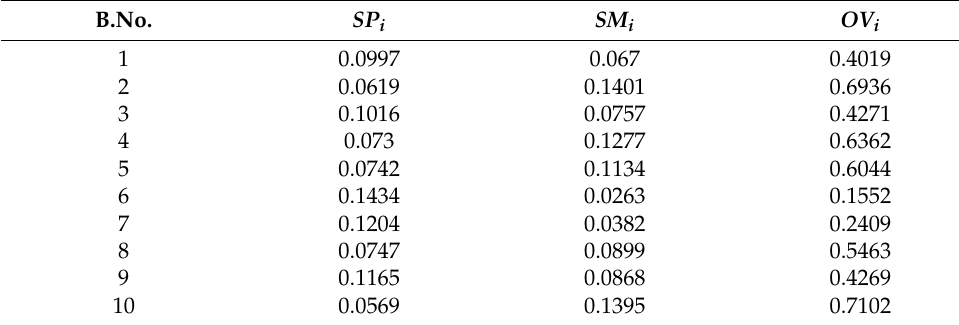
Table A5. Ideal, negative ideal and relative closeness values.